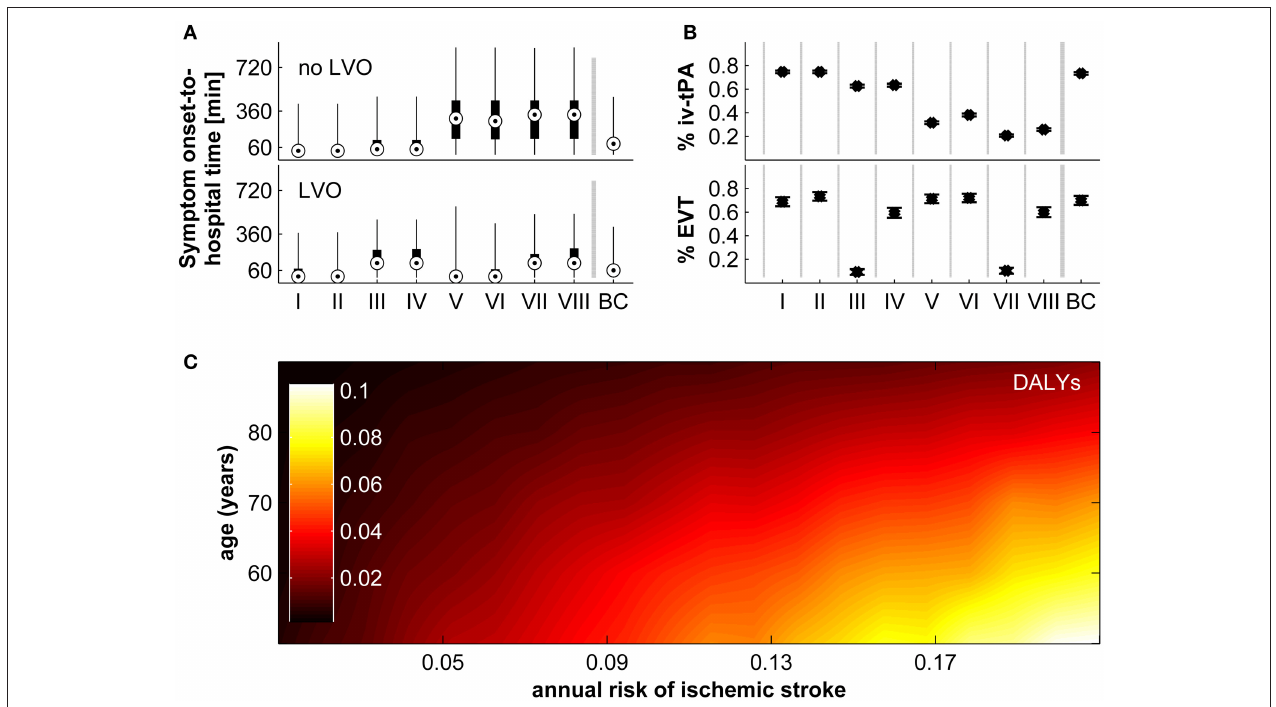
FIGURE 2 | Impact of real-time stroke detection. (A) Reduction of symptom onset-to-hospital time for patients with and without large vessel occlusion (LVO) in socio-geographic scenarios I–VIII and in the base-case scenario (BC). Shown are the median (circles), interquartile range (black boxes), and full range. (B) Proportion of all patients with acute ischaemic stroke fulfilling time-based eligibility criteria for thrombolysis (top), and proportion of all patients with acute ischaemic stroke with LVO fulfilling the time-based eligibility criteria for mechanical thrombectomy (bottom). Shown are the median (circles), interquartile range (black boxes), and full range. (C) Disability adjusted life-years (DALYs) preventable by real-time stroke detection according to age and annual risk for ischaemic stroke assuming parameters of the base-case scenario. For a definition of socio-geographic scenarios, see main text and Table 7